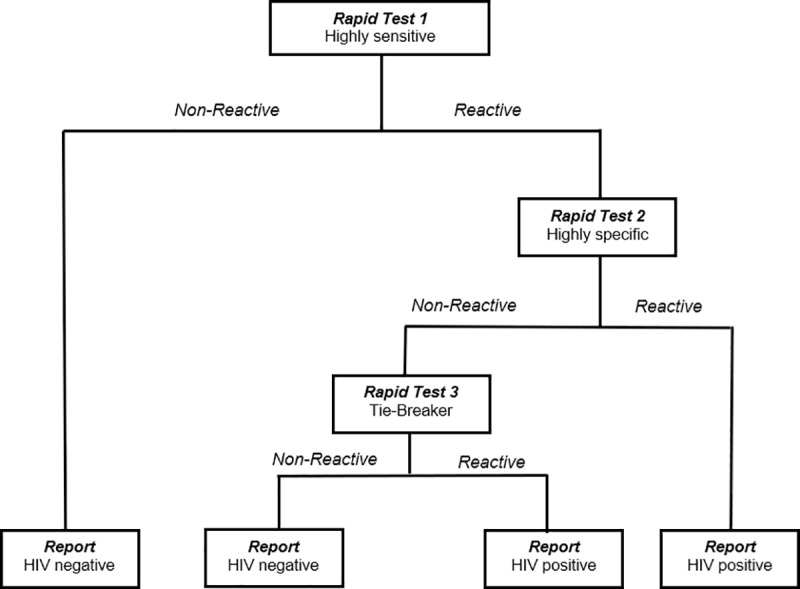
. National algorithm for HIV rapid testing.